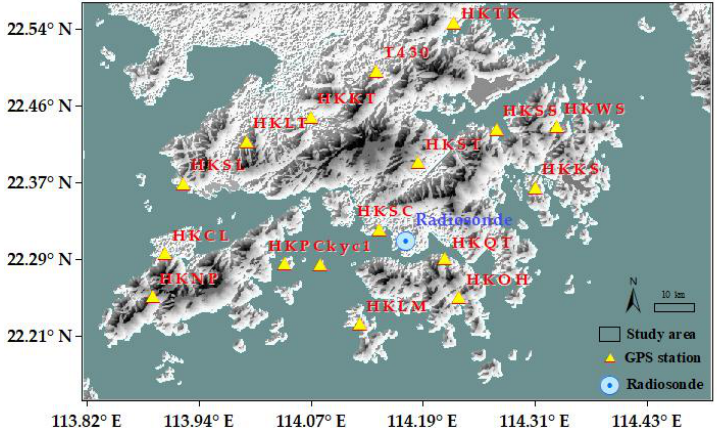
Figure 1. Map of the study area showing the satellite positioning reference stations in HK.